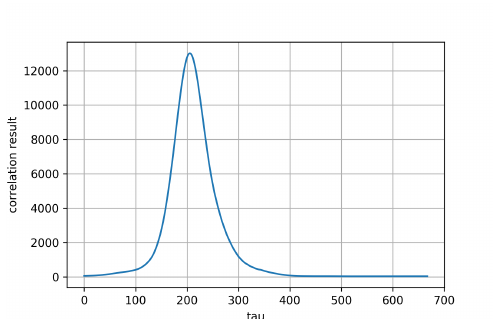
Figure 16. Result of cross-correlation. Cross-correlation measures the similarity of two signals. τ is the time lag, which is applied to g ( i ) . We can see that the two signals have the highest similarity when τ =